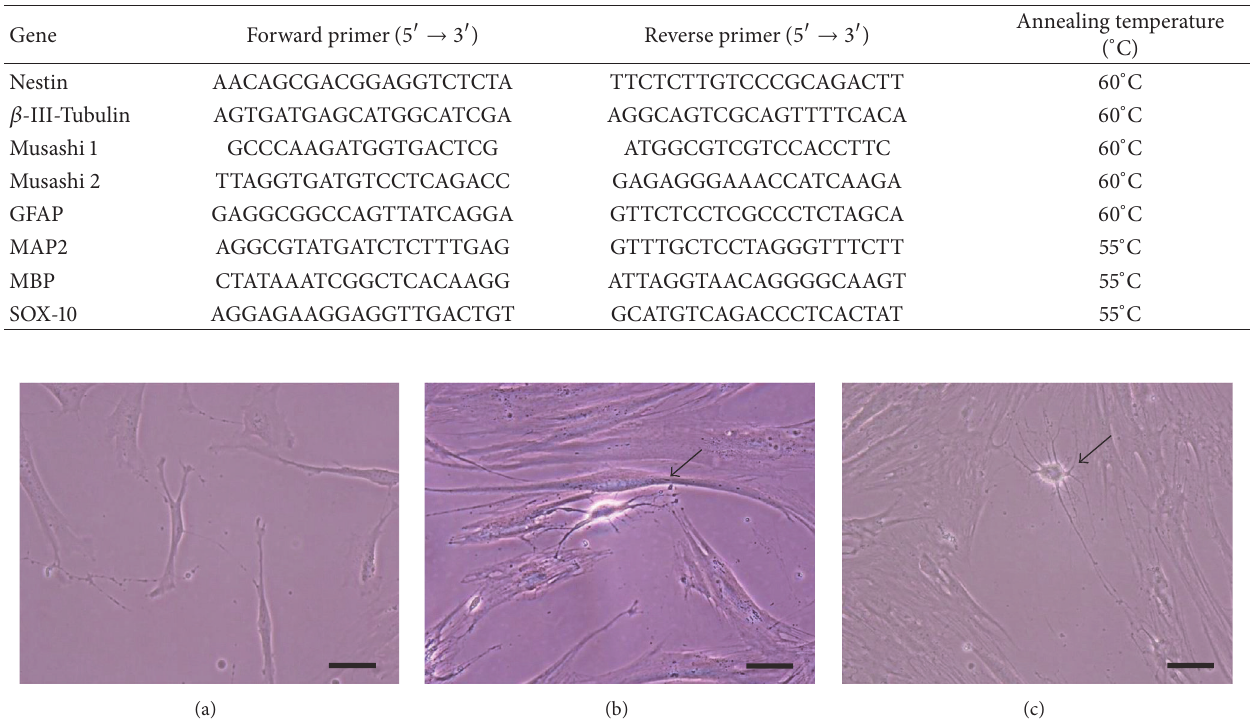
a fibroblast-like spindle-shaped morphology (culture day